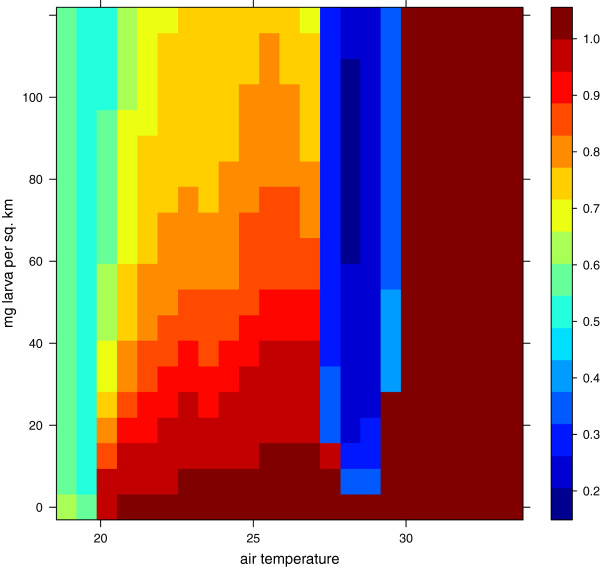
Fraction of An. arabiensis  as a function of air temperature and carrying capacity. The water temperature is set to the same value as the air temperature unless the temperature is greater than 33°C (at which most pupae would not develop into adults [144]). In this case the water temperature is set to 33°C, but the productivity will remain low. The fraction of An. gambiae s.s. is one minus the fraction for An. arabiensis.